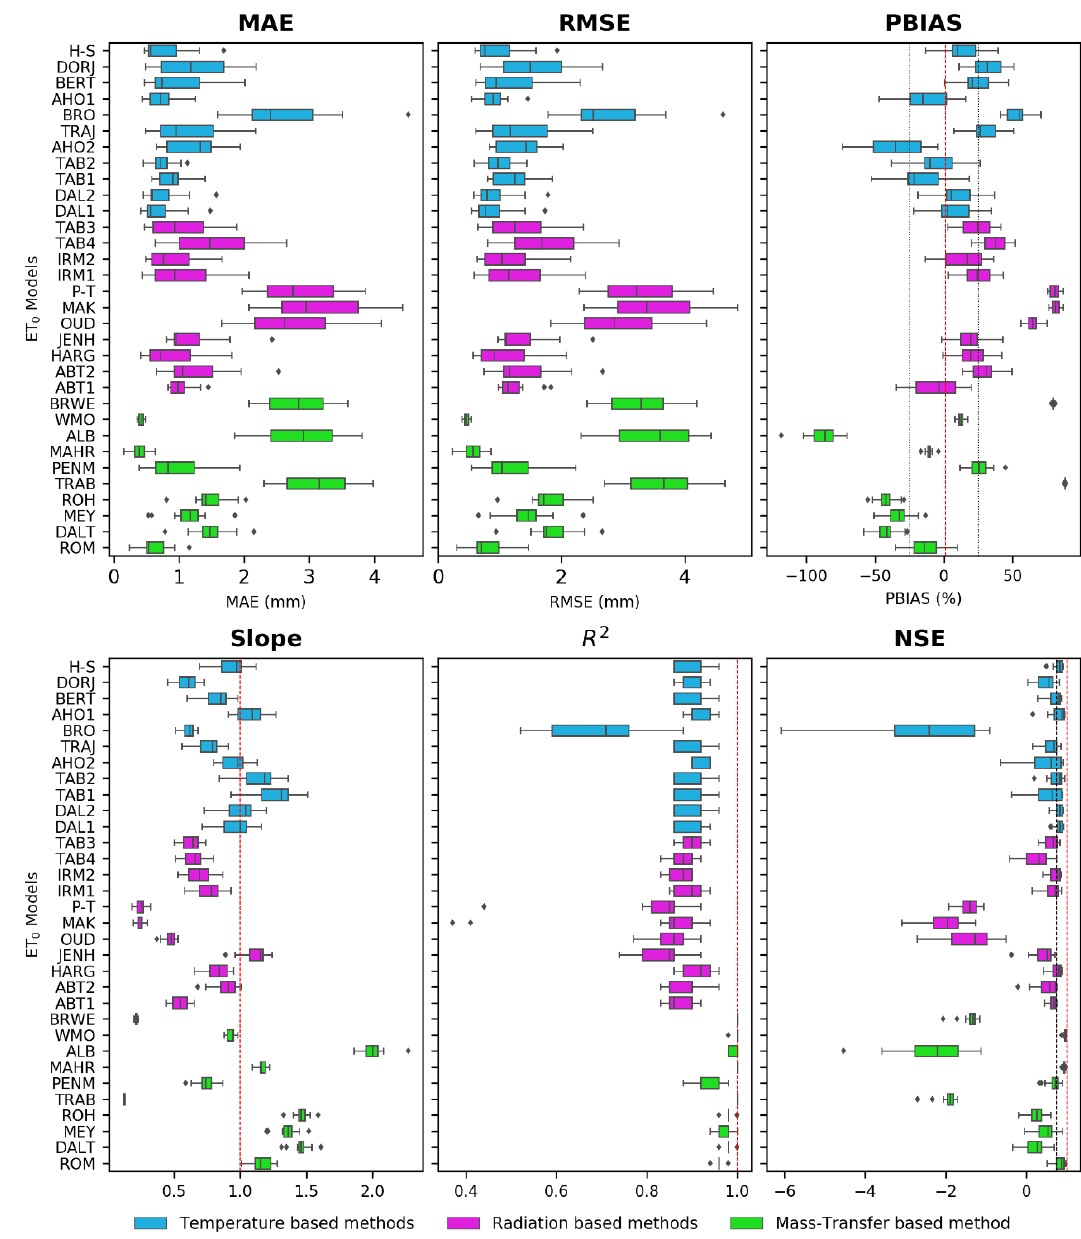
Figure 3. Performance of 32 ET 0 methods according to the selected evaluation metrics on monthly data in the Hexi Corridor, ( a ) mean absolute errors ( MAE ), ( b ) root mean square errors ( RMSE ), ( c ) percentage bias ( PBIAS ), ( d ) regression slope(Slope), ( e ) coefficient of determination ( R 2 ), and ( f ) Nash–Sutcliffe efficient ( NSE ).